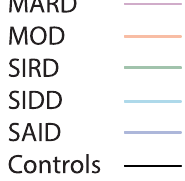
Fig. 4 | Proteins that distinguish individual diabetes subtypes ( N =420 indivi- duals). The dots and bars represent the mean protein values and the 95% con- fi denceintervalsofthe means forproteinsthat aredifferent inone ofthe four T2D subtypes compared to all others. Values are normalized by the mean of the